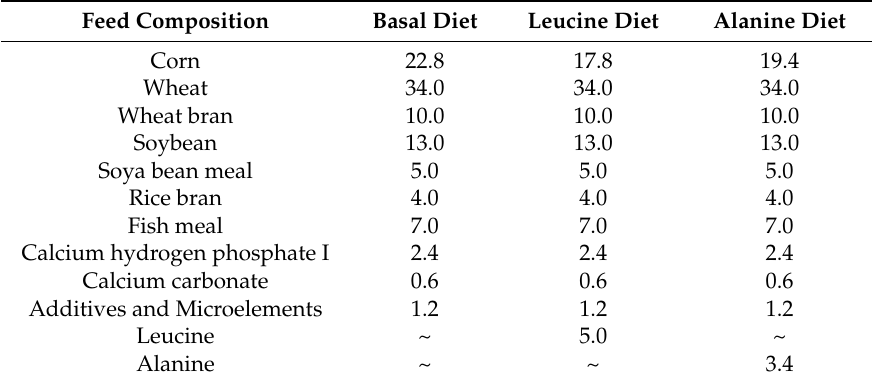
Table 1. Diet formulation (%).